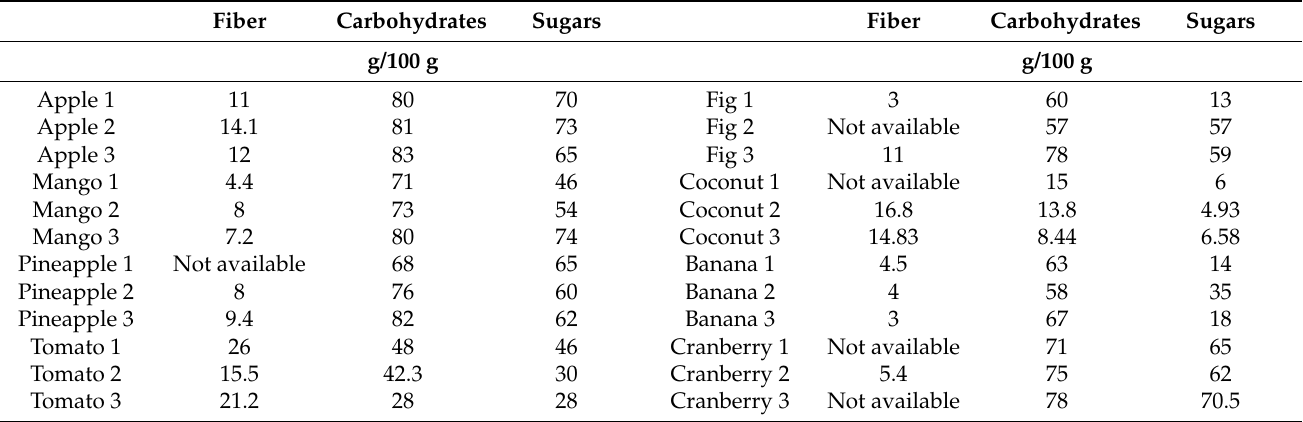
Table 2. Fiber, carbohydrates, and sugar content (g) per 100 g of commercial dried fruits (label